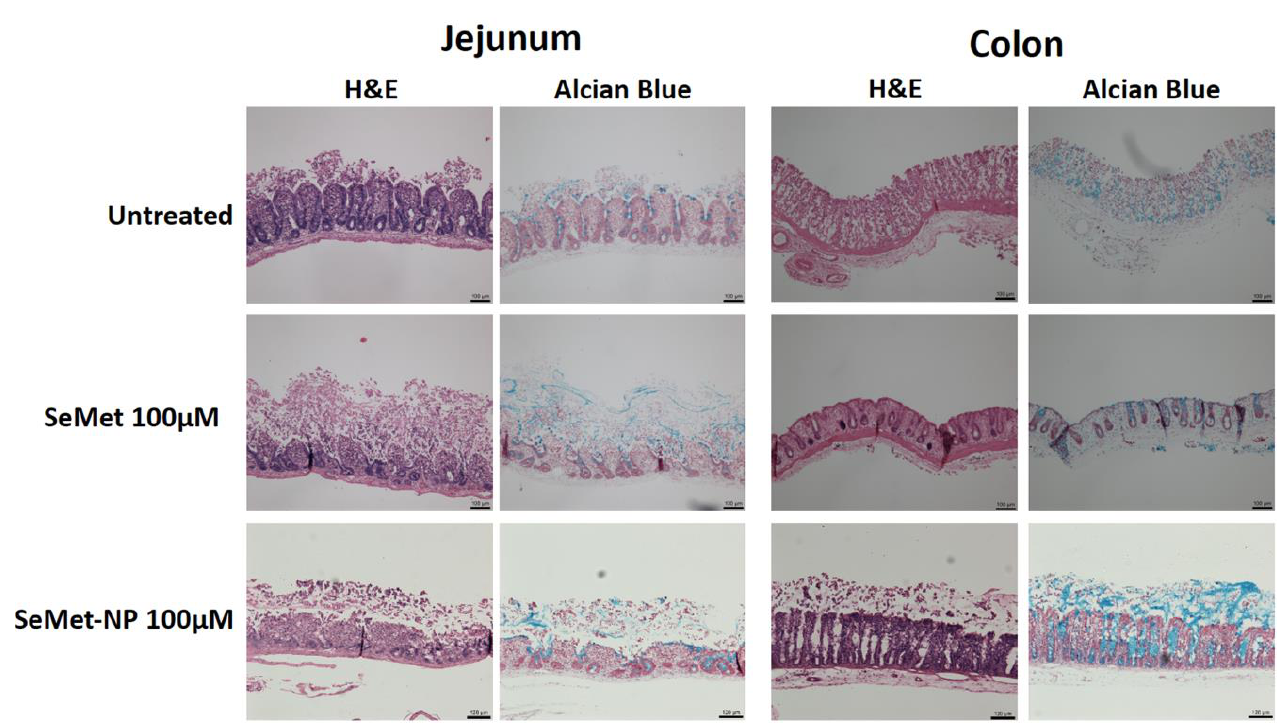
Figure 5. Representative H&E and Alcian Blue staining of rat jejunal and colonic mucosae in adapted horizontal diffusion chambers following a 2 h exposure with SeMet and SeMet-NPs compared to untreated tissue. Black arrows indicate erosion of epithelial layer. Horizontal bars in each panel = 100 μm.